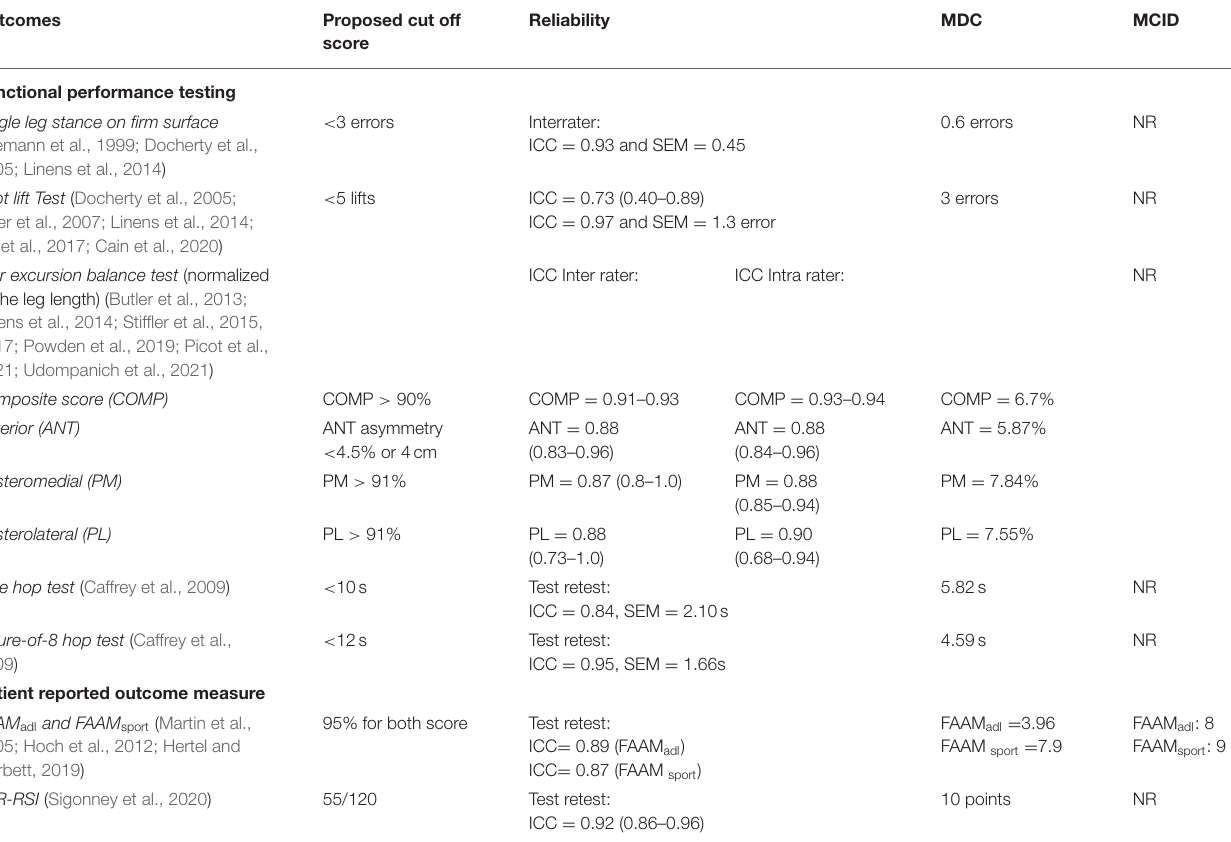
TABLE 1 | Summary of main functional tests and patient reported outcome measures (PROM) as relevant return to sport criteria. Outcomes